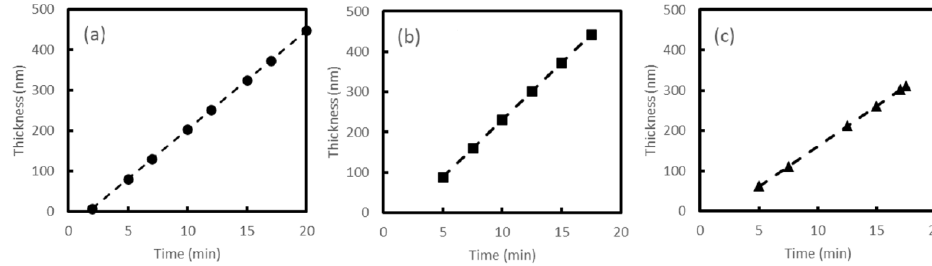
Figure 1. Deposition rates of coatings: ( a ) TiSi, ( b ) ALTi, and ( c )